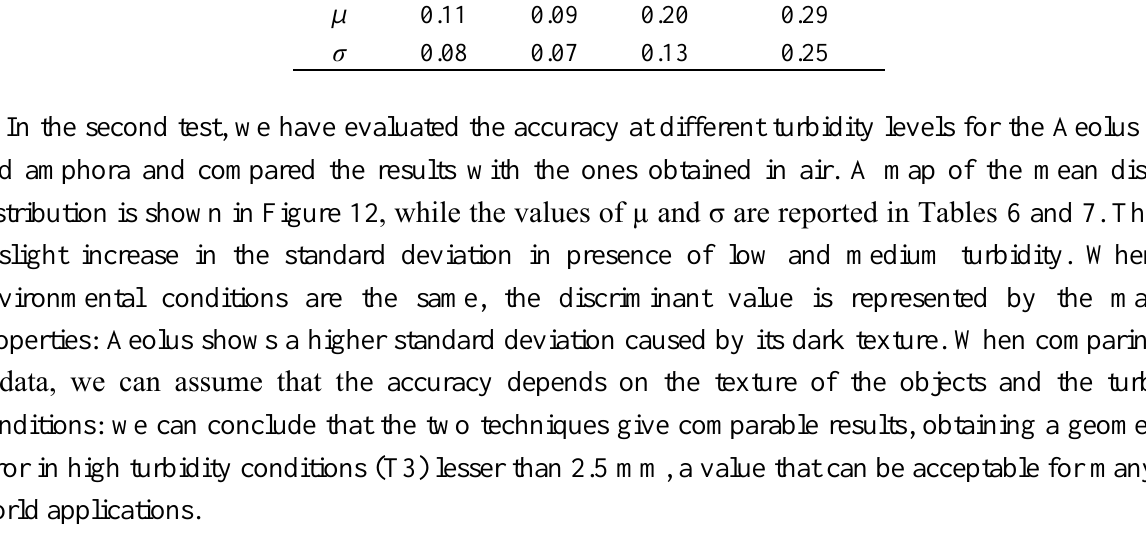
Figure 12. Map of mean distance distribution for the Aeolus